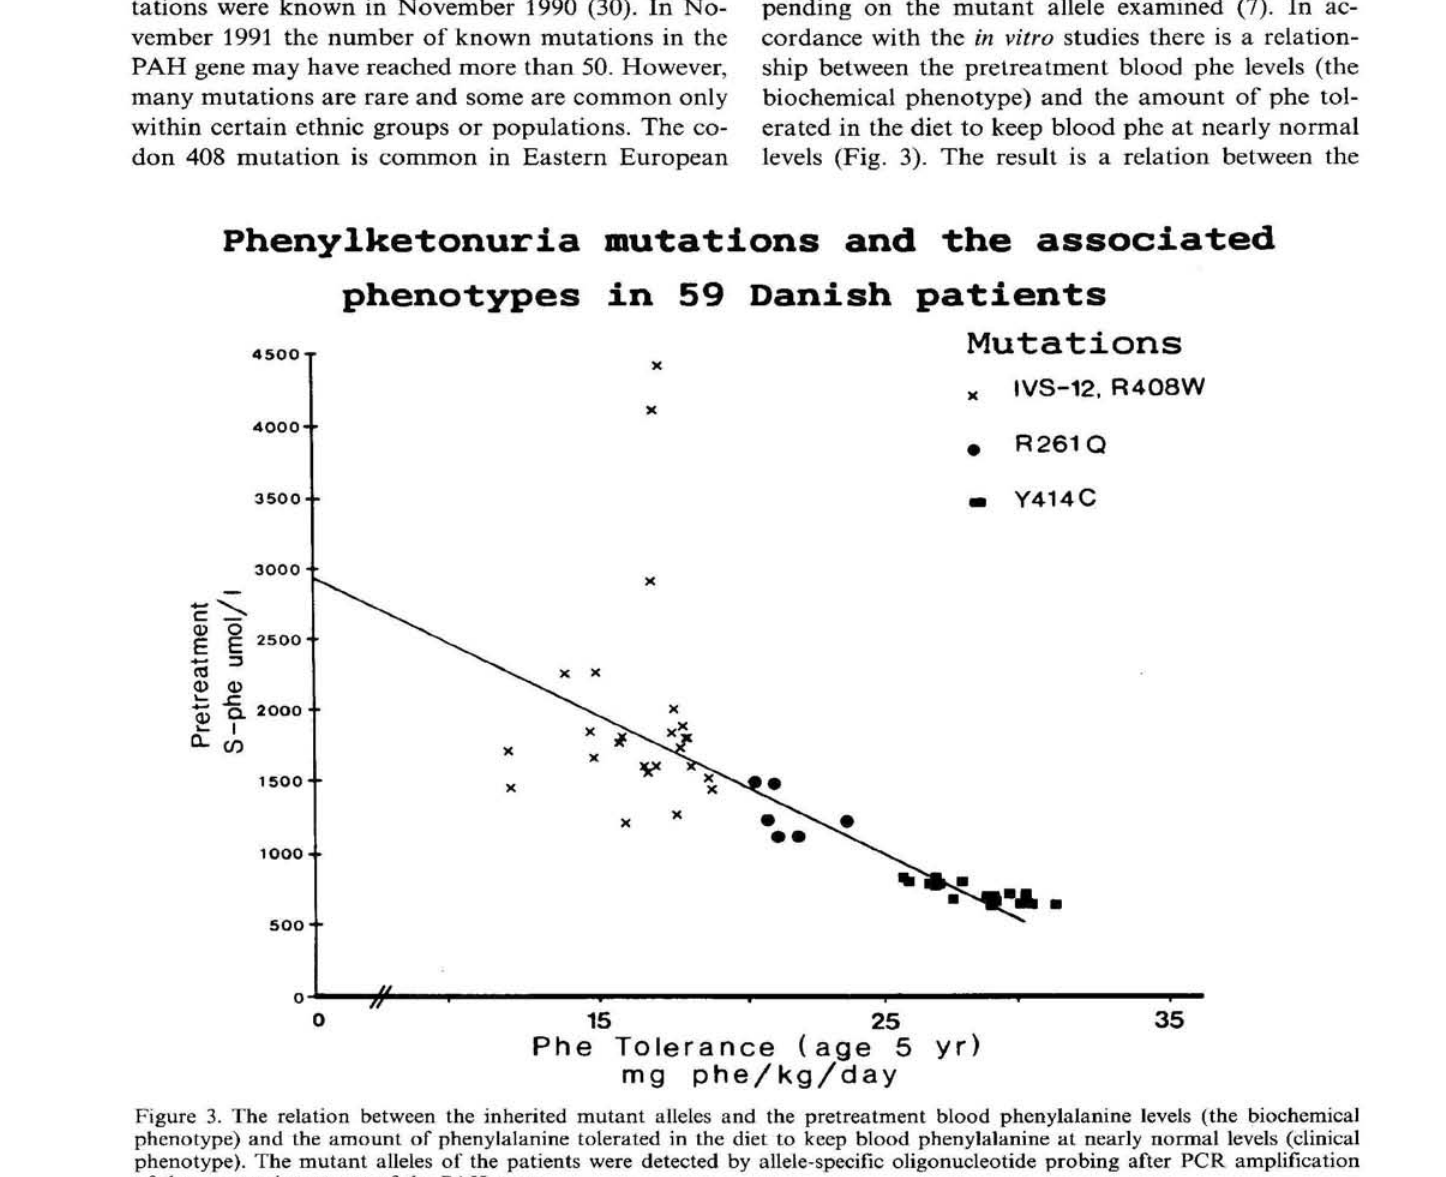
Figure 3. The relation between the inherited mutant alleles and the pretreatment blood phenylalanine levels (the biochemical phenotype) and the amount of phenylalanine tolerated in the diet to keep blood phenylalanine at nearly normal levels (clinical phenotype). The mutant alleles of the patients were detected by allele-specific oligonucleotide probing after PCR amplification of the appropriate exons of the PAH